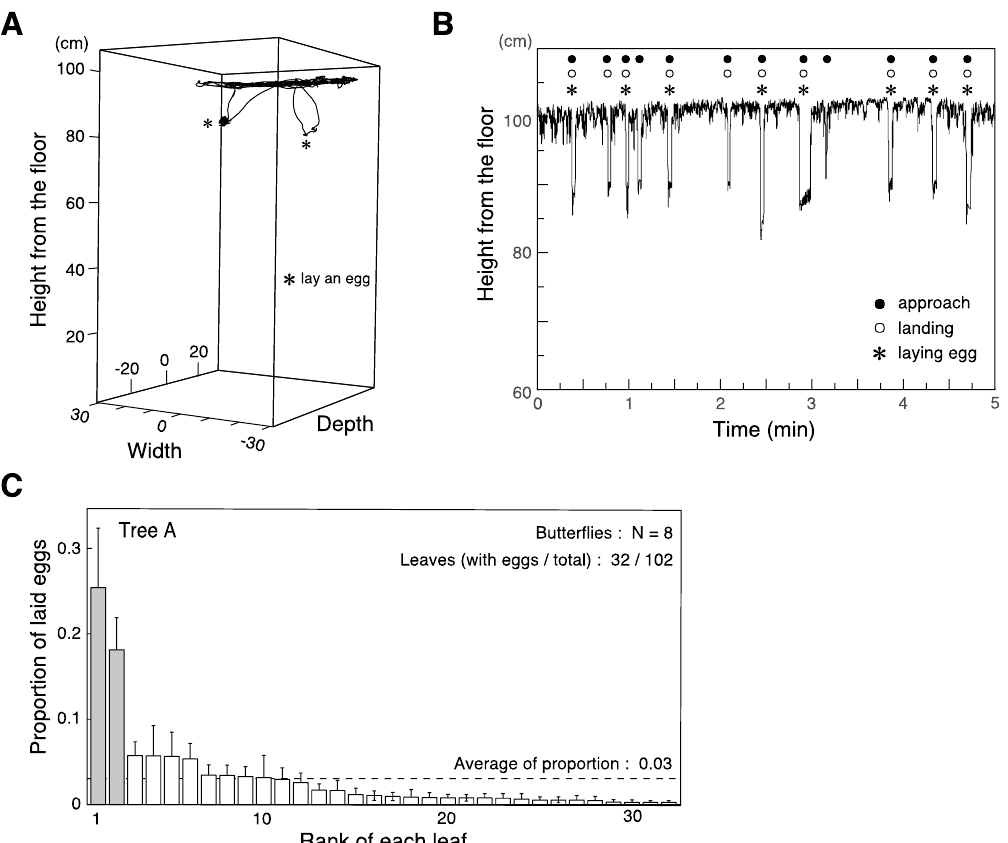
Figure 3. Observation of ovipositing behavior. ( A ) 3D flight trajectory of a butterfly over three min. * denotes instances where it laid eggs. ( B ) Flight altitude during ovipositing behavior. The animal flies close to the ceiling, intermittently making distinct descents to approach leaves. ( C ) Mean proportions of eggs laid on leaves of a single tree by eight individuals. Two leaves (gray bars) received a significantly higher proportion than the chance baseline, shown as a dashed line. Table 1. Five morphological and four reflective features of favored and unfavored leaves (25 leaves for each type). Mean value (± SE ) of twenty-five leaves for favored and unfavored leaves. p value is obtained by Wilcoxon ranked sum test.